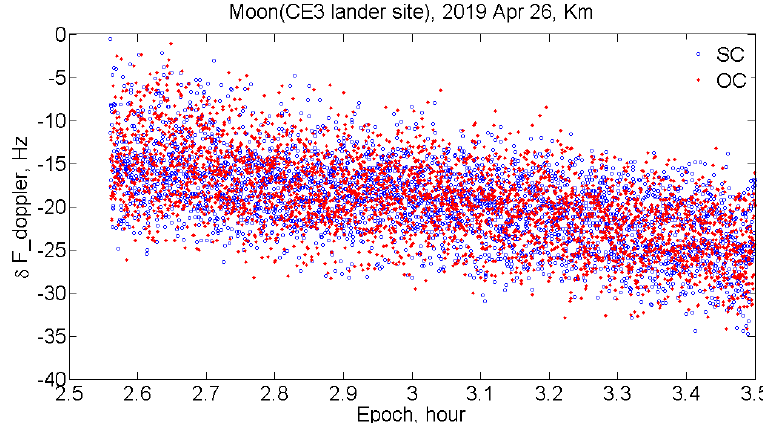
Figure 2. The di ff erence between measured and calculated Doppler frequency shifts for SC and OC Figure 2. The difference between measured and calculated Doppler frequency shifts for SC and OC echoes, echoes, respectively.